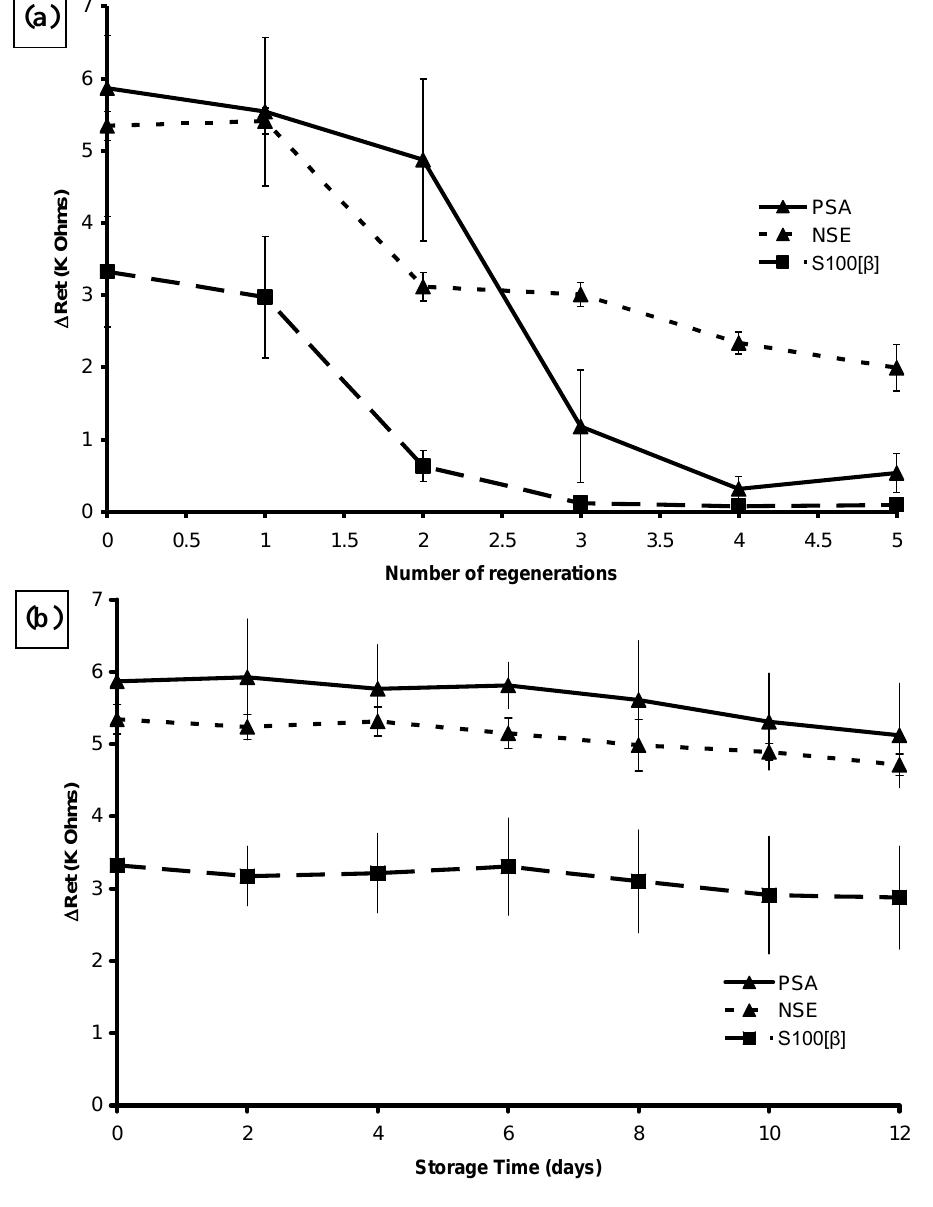
Figure 25. Effect of (a) regeneration and (b) storage on the mean change in electron transfer resistance at 100 pg mL –1 antigen for affinity-immobilised